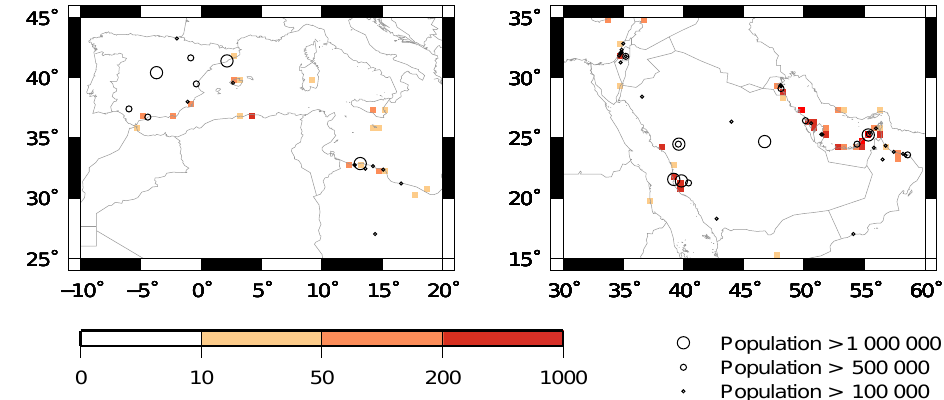
Figure 1. Actual locations of major desalination plants in the Mediterranean and Middle East in 2005. Boxes and circles represent plants (in 1000m 3 day − 1 of capacity; DesalData) and major cities (GeoNames), respectively.